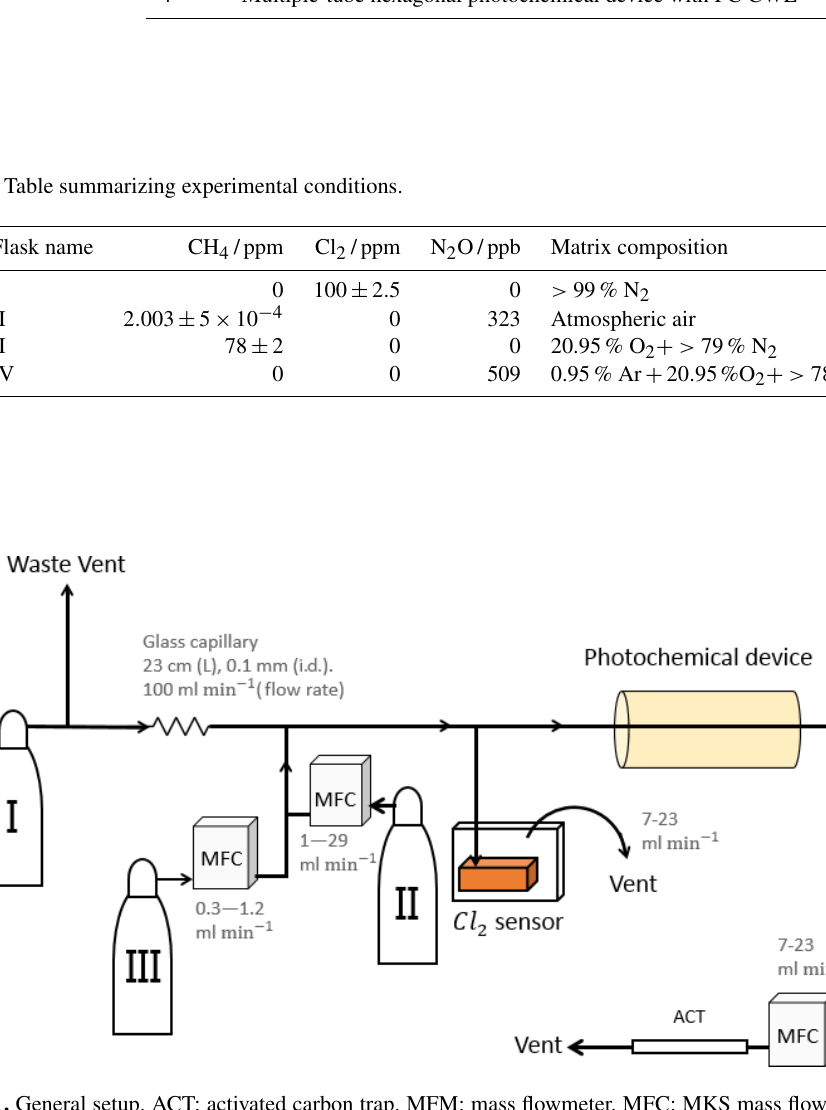
Figure 1. General setup. ACT: activated carbon trap. MFM: mass flowmeter. MFC: MKS mass flow controller GE50A. MFC: manual flow controller. Table 2: gas flask. Four variations of the general setup are performed. The setup variations and the experiments performed with the setups are shown in Table 1. Setup 1 uses a xenon lamp as the photochemical device. Setups 2–4 use the same photochemical device, which consists of 420 LEDs. The chamber tube used in setups 1–3 is one quartz tube (20cm length × 12.7mm o.d.), while setup 4 uses seven smaller quartz tubes: five with the size 8.33mm (o.d.), 6.33mm (i.d.) and 20cm (L), as well as two with the size 8.33mm (o.d.), 6.33mm (i.d.) and 25cm (L). The setups also differ in the chlorine waste line. Setups 1–2 use a flow-controlled chlorine waste line, while setup 3.4 uses a pressure-controlled chlorine waste